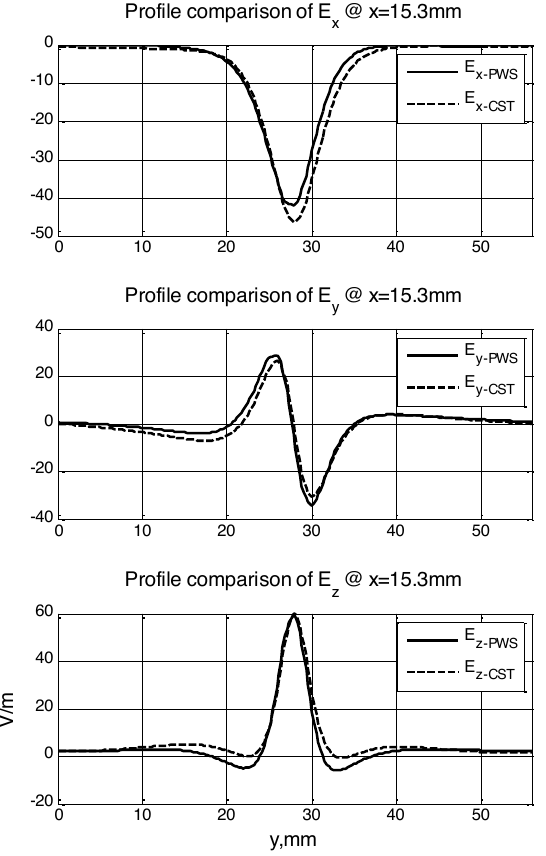
Figure 21: Comparisons of the electric field components profiles obtained from the proposed PWS computation method and the CST simulation, detected in the vertical cut- plan x =